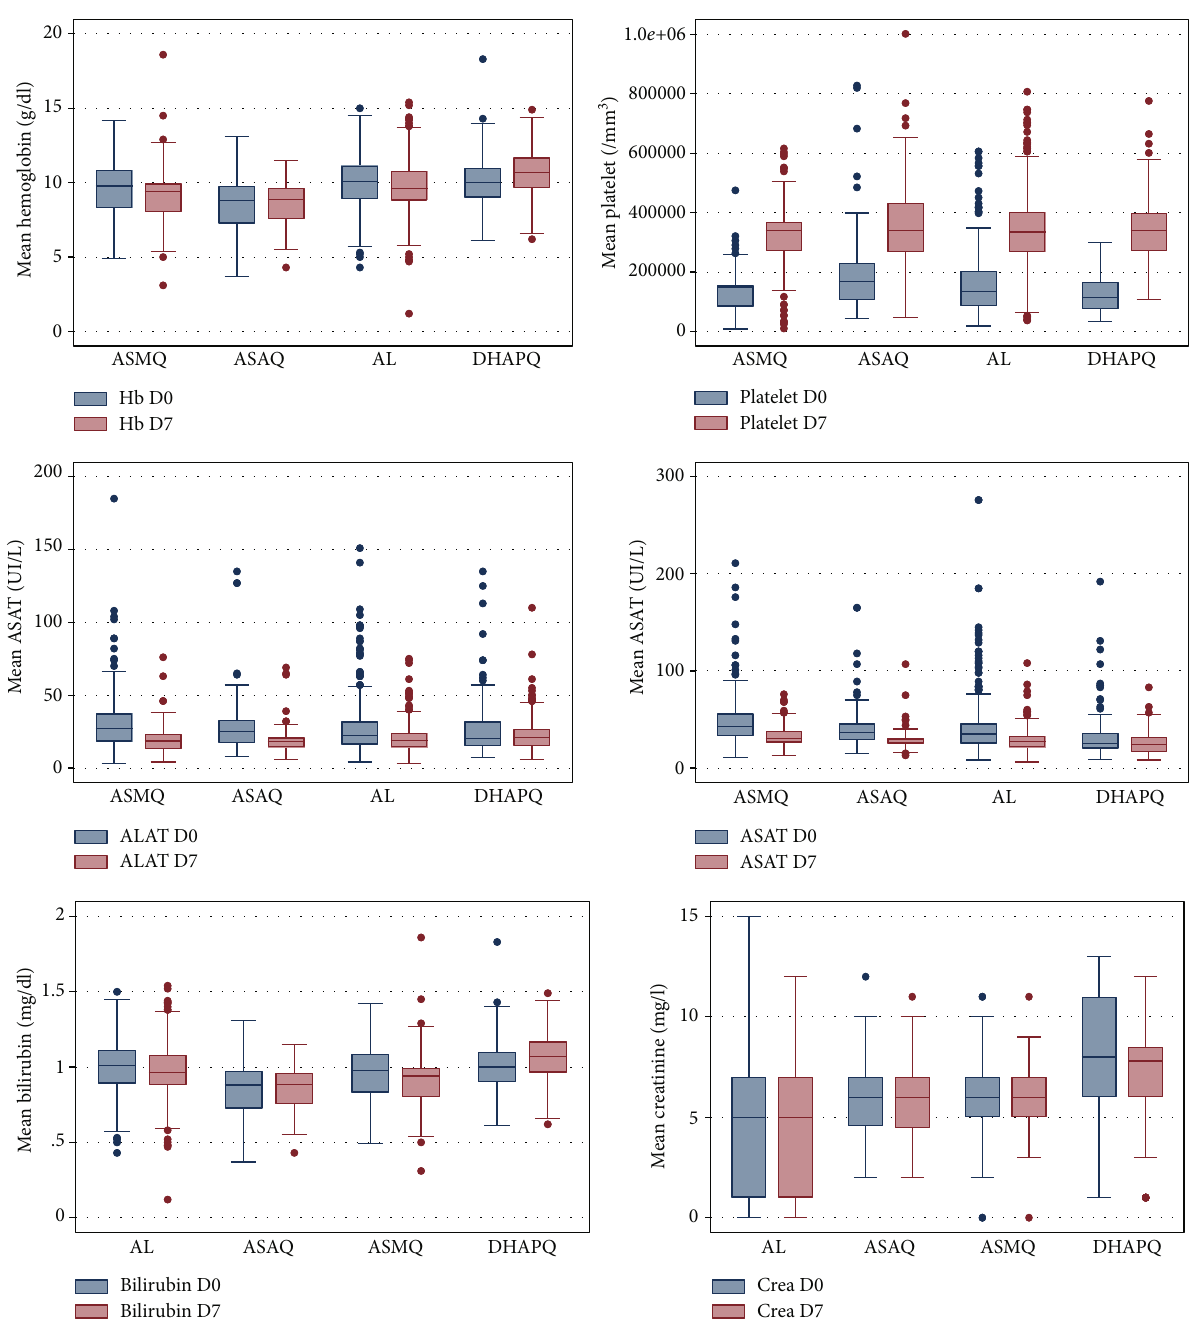
Figure 1: Mean hematologic and biochemical values by treatment at D0 and D7 in patients with uncomplicated Plasmodium falciparum malaria. Units for hemoglobin (g/dl), units for platelets (/mm 3 ), units for ALAT and ASAT (IU/l), units for bilirubin (mg/dl), and units for creatinine